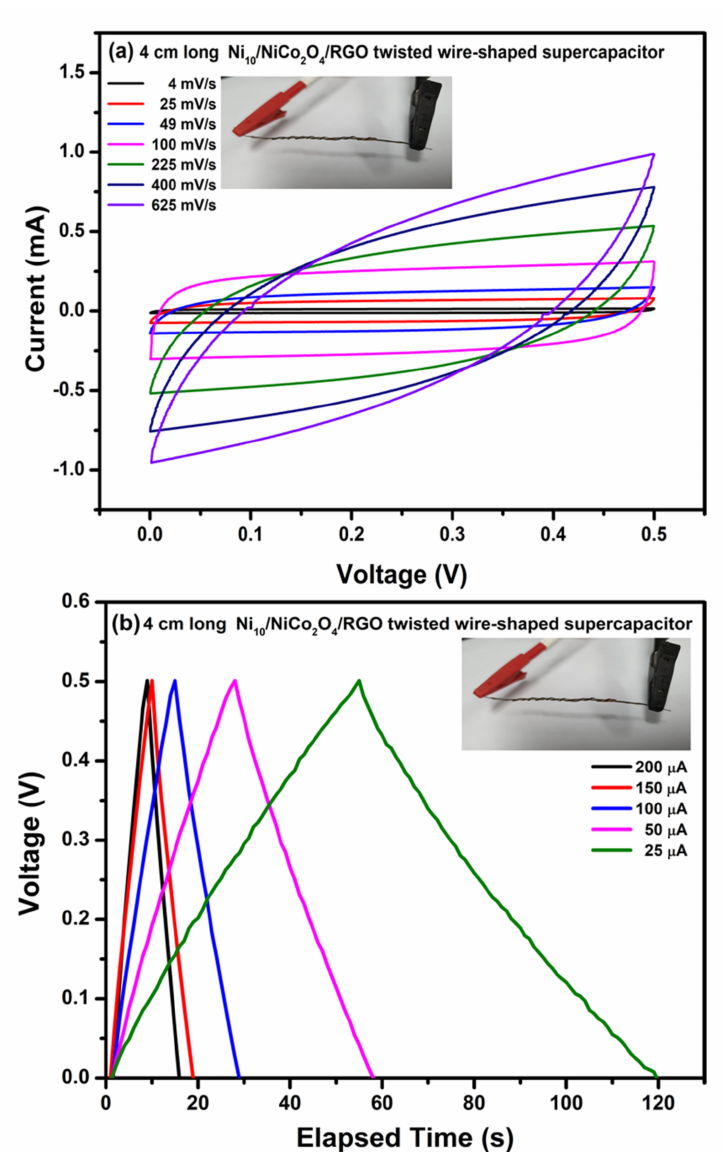
Figure 11. Electrochemical characterization of 4 cm long Ni 10 /NCO/RGO twisted WSC: ( a ) CV curves at various scan rates under 0–0.5 V potential window and ( b ) GCD curves at different applied